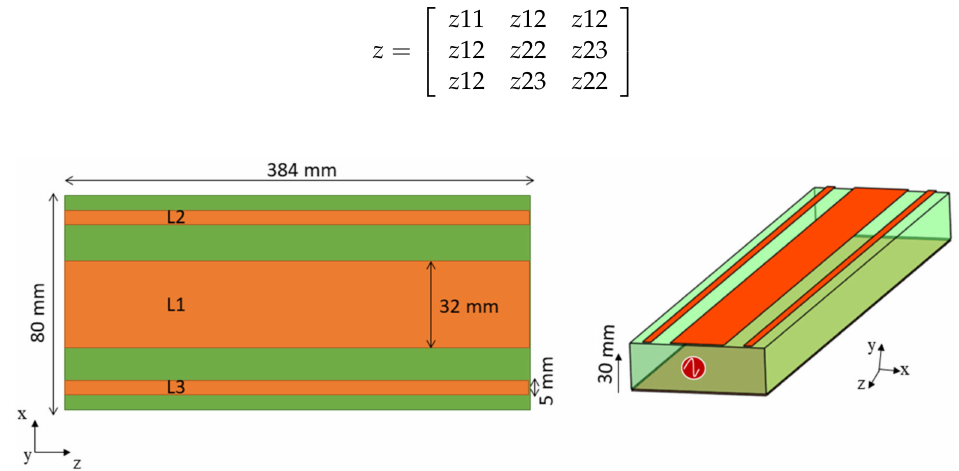
Figure 1. The geometry of triple-line microstrip-transmission line with the respective dimensions. The solution is given